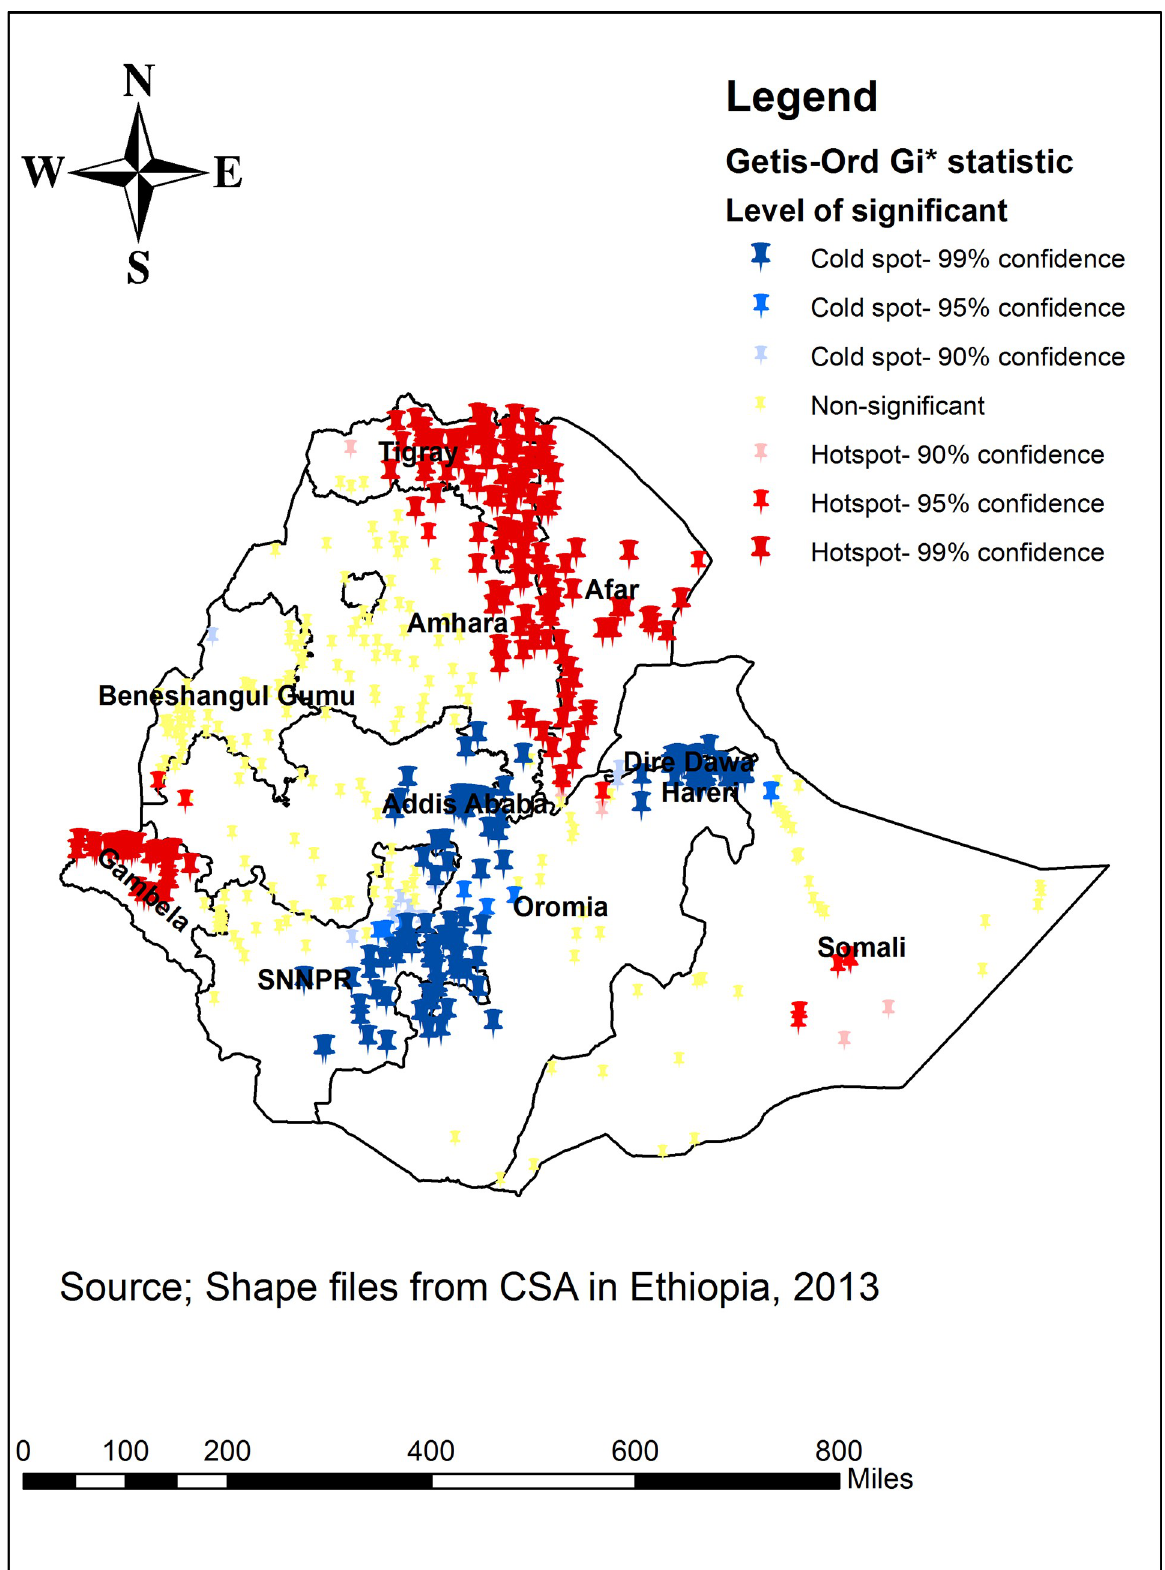
Fig 3. Hotspot and Cold spot underweight across regions among individuals aged 15–49 years in Ethiopia, 2016. https://doi.org/10.1371/journal.pone.0242744.g003 PLOS ONE | https://doi.org/10.1371/journal.pone.0242744 December1,